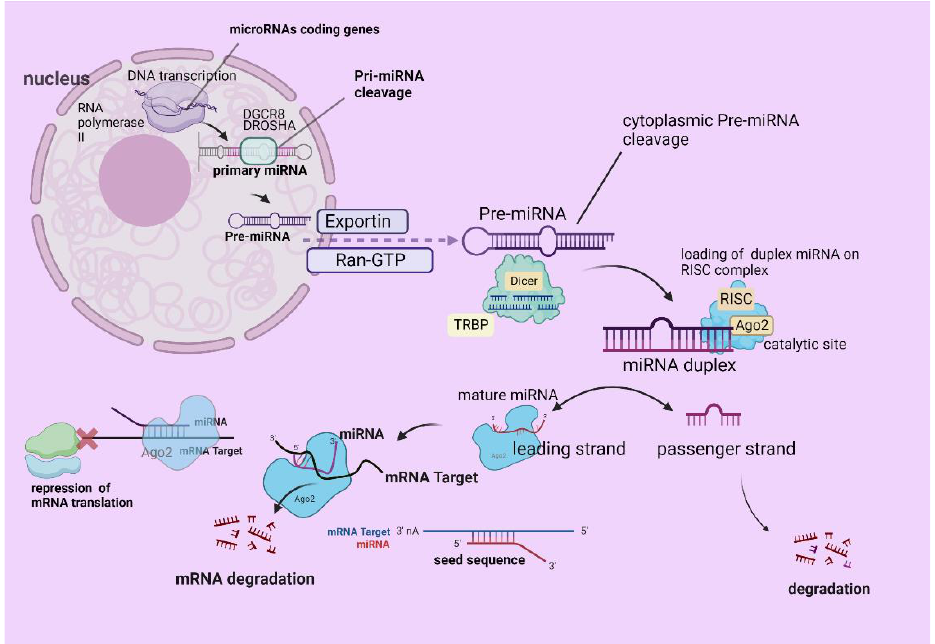
Figure 1. A schematic presentation of miRNA biogenesis. The mechanism of miRNAs biogenesis starts with DNA transcription of specific miRNAs coding genes, under the enzymatic action of RNA polymerase II inside the nucleus. Pri-miRNA arises and is cleaved under the action of DGCR8–Drosha (ribonuclease III), giving rise to pre-miRNA, which is relocated to the cytoplasm via Exportin 5 and Ran-GTP. Pre-miRNA then is cleaved by the Dicer-TRBP, forming the duplex miRNA, which is further loaded on the RISC complex. The active miRNA strand (leading strand/mature miRNA) is loaded on RISC (miRISC) and the other is the so-called passenger, which becomes degraded. The miRISC (seed sequence) binds a target mRNA, which leads to the repression of the mRNA translation, as well as its silencing or degradation. The figure was created with “BioRender.com” (agreement number OS252V998Q).